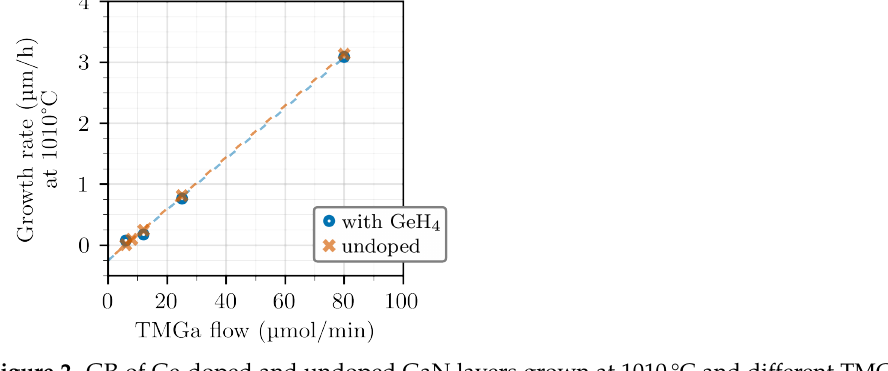
Figure 2. GR of Ge-doped and undoped GaN layers grown at 1010°C and different TMGa flows. The GR of the doped layers is interpolated from the data of Figure 1a. Note that the data for doped and undoped layers overlap on the same line and that this line crosses the x -axis for a TMGa flow of